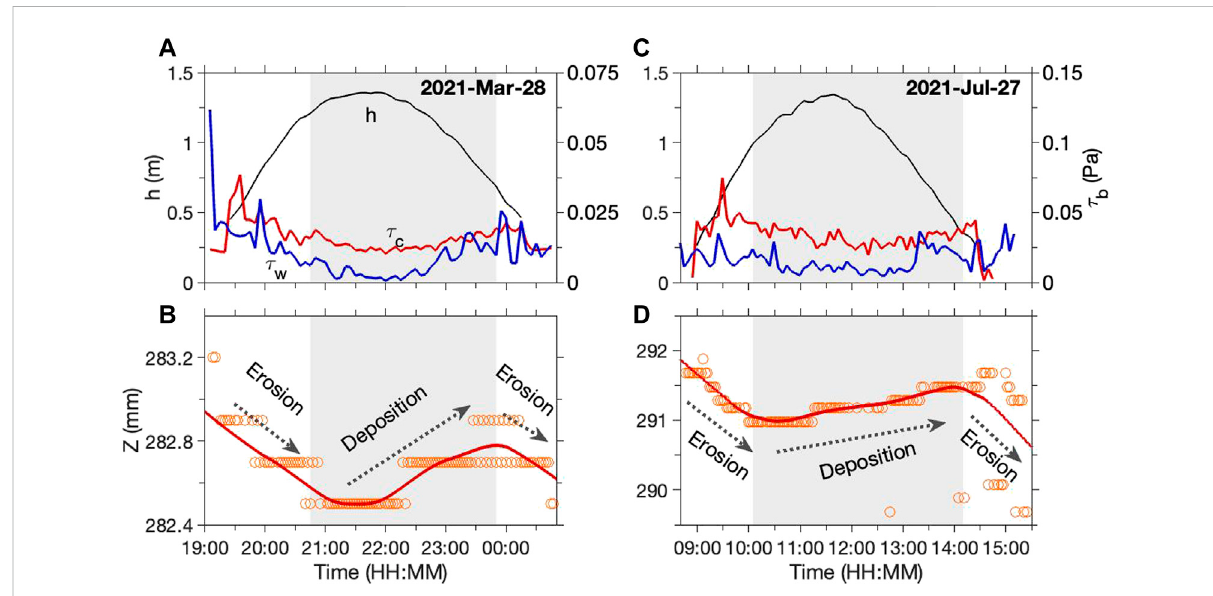
FIGURE 6 Timeseriesofwaterdepth( h ),wave-inducedbedshearstress( τ w ),current-inducedbedshearstress( τ c ),relativebedlevel( Z ,orangecircle)and smoothed bed level (red line) of the calm tidal cycles. Bed erosion occurs in fl ood and ebb peaks, while deposition during slack